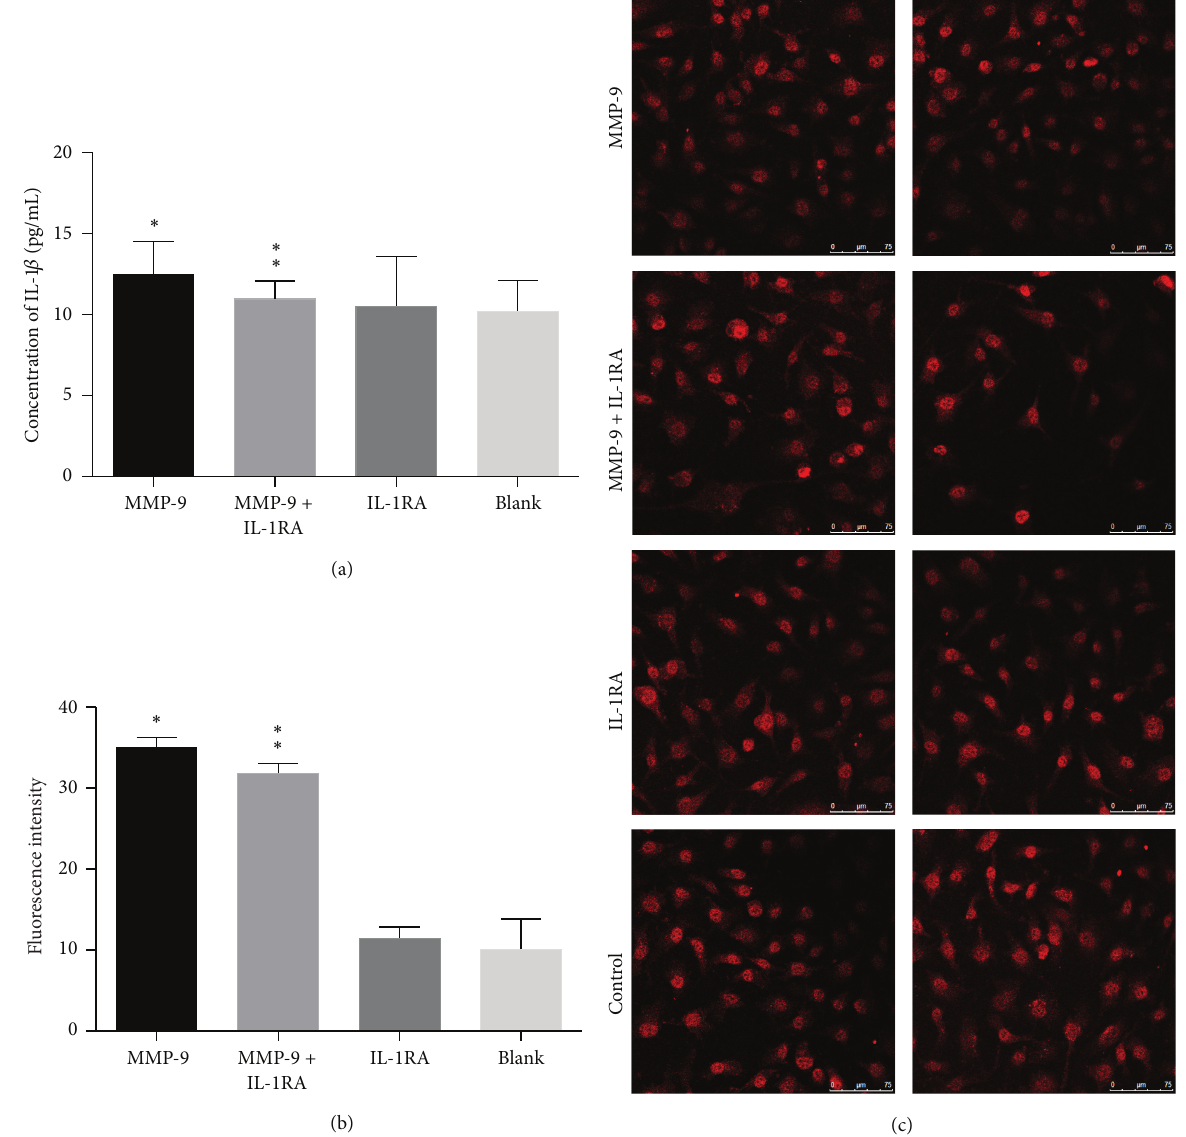
Figure 6: BzATP-induced tight junction disruption and endothelial coculture system hyperpermeability were attenuated by MMP inhibition. (a) The levels of IL-1 𝛽 were not significantly altered in MMP-9-treated groups versus control groups ( ∗ 𝑃 > 0.05 ). No statistically significant differences were found between IL-1RA + MMP-9 groups and MMP-9 groups in the levels of IL-1 𝛽 ( ∗∗ 𝑃 > 0.05 ). (b) Exposure to MMP-9 significantly increased the permeability to FITC-dextran compared with the control group ( ∗ 𝑃 < 0.05 ). However, IL-1RA failed to attenuate MMP-9-induced paracellular hyperpermeability ( ∗∗ 𝑃 > 0.05 ). (c) Immunofluorescence staining showed that the expression of ZO-1 and occludin in MMP-9 groups was significantly decreased compared with controls, while IL-1RA + MMP-9 groups showed no improvement in the levels of the two tight junction